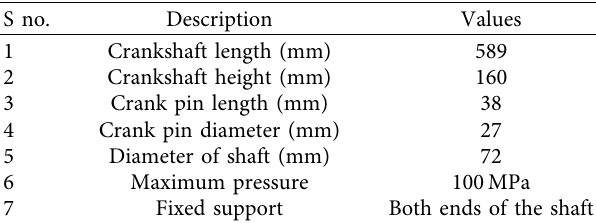
Table 1: Geometrical dimensions of the crankshaft.